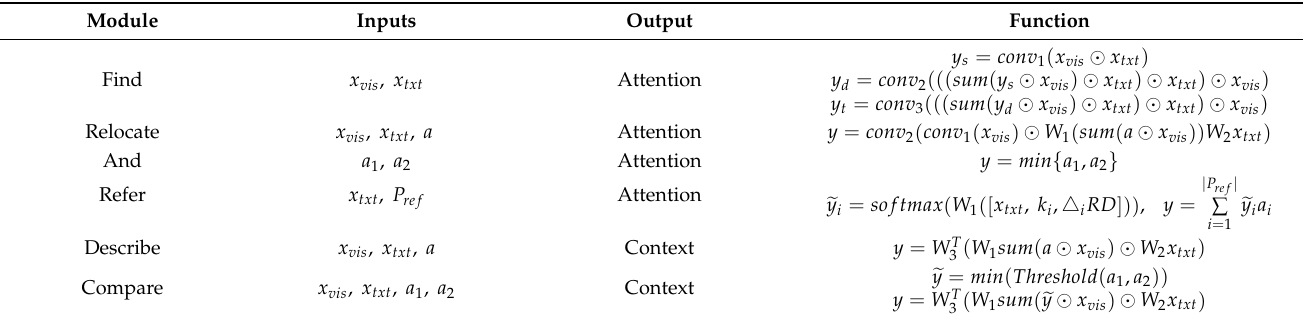
Table 1. Neural network modules for visual dialog.